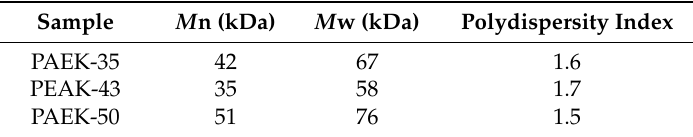
Table 1. Average molecular weights and polydispersity index of PAEKs.